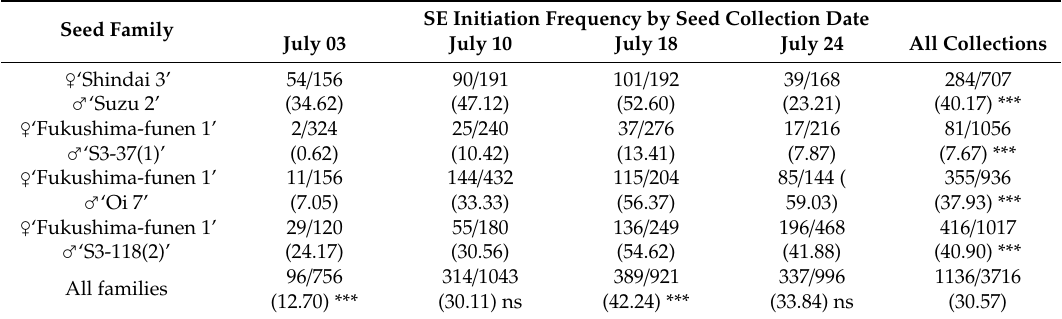
Table 1. SE initiation frequency of sugi seed families carrying the male sterility gene MS1 . Data represent the explants with SE initiation response / total number of explants tested; and the numbers in the parentheses represent the initiation frequency (%) for each family at four di ff erent seed collection dates.